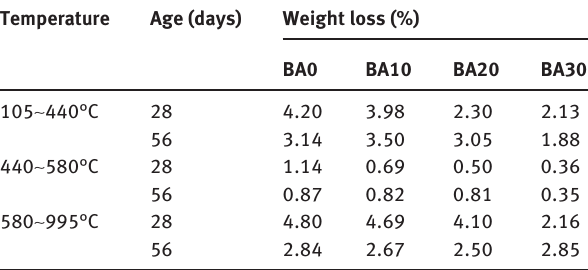
Table 5 Weight loss of cement-based composites.